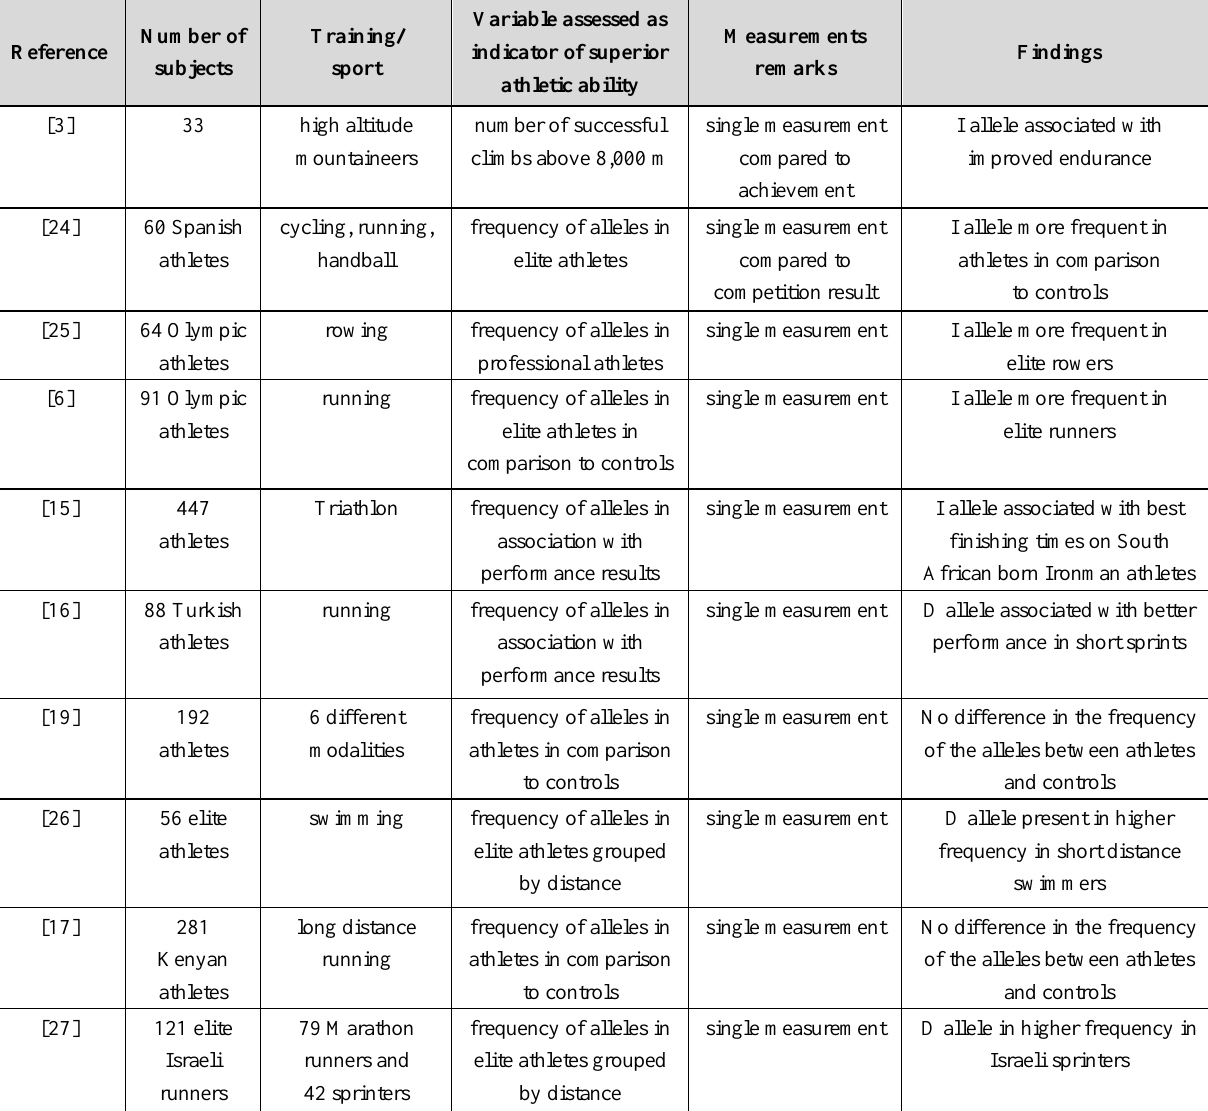
Table 2. Summary of studies that focused on performance results and its association with the ACE I/D polymorphism, or frequency of I/D alleles, in athletes, in comparison to